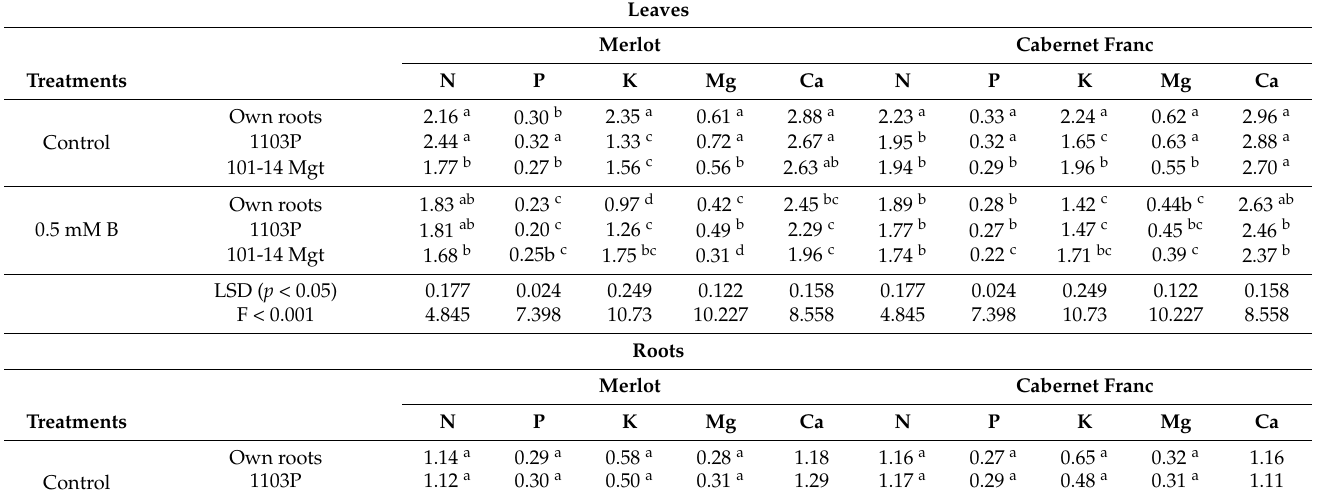
Table 4. The effect of boron toxicity on N, P, K, Mg and Ca (% d.w.) concentration in different parts of Merlot and Cabernet Franc vines on own roots or grafted to 1103P and 101-14 Mgt rootstocks. Leaves Merlot Cabernet